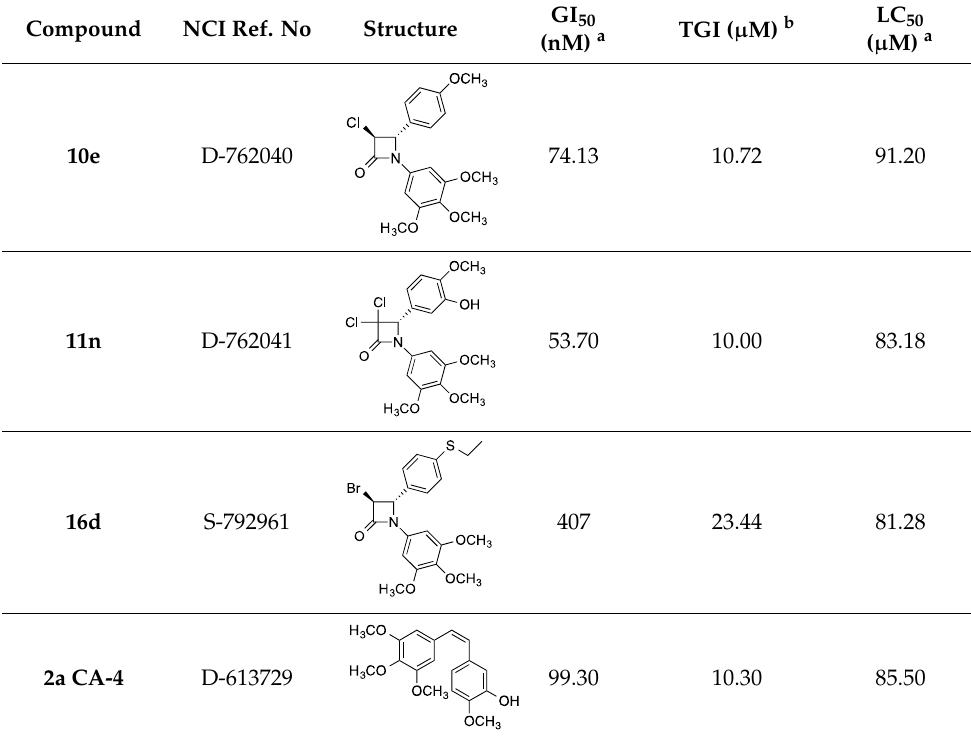
Table 7. Summary of NCI 60 cell line screening results for selected compounds.